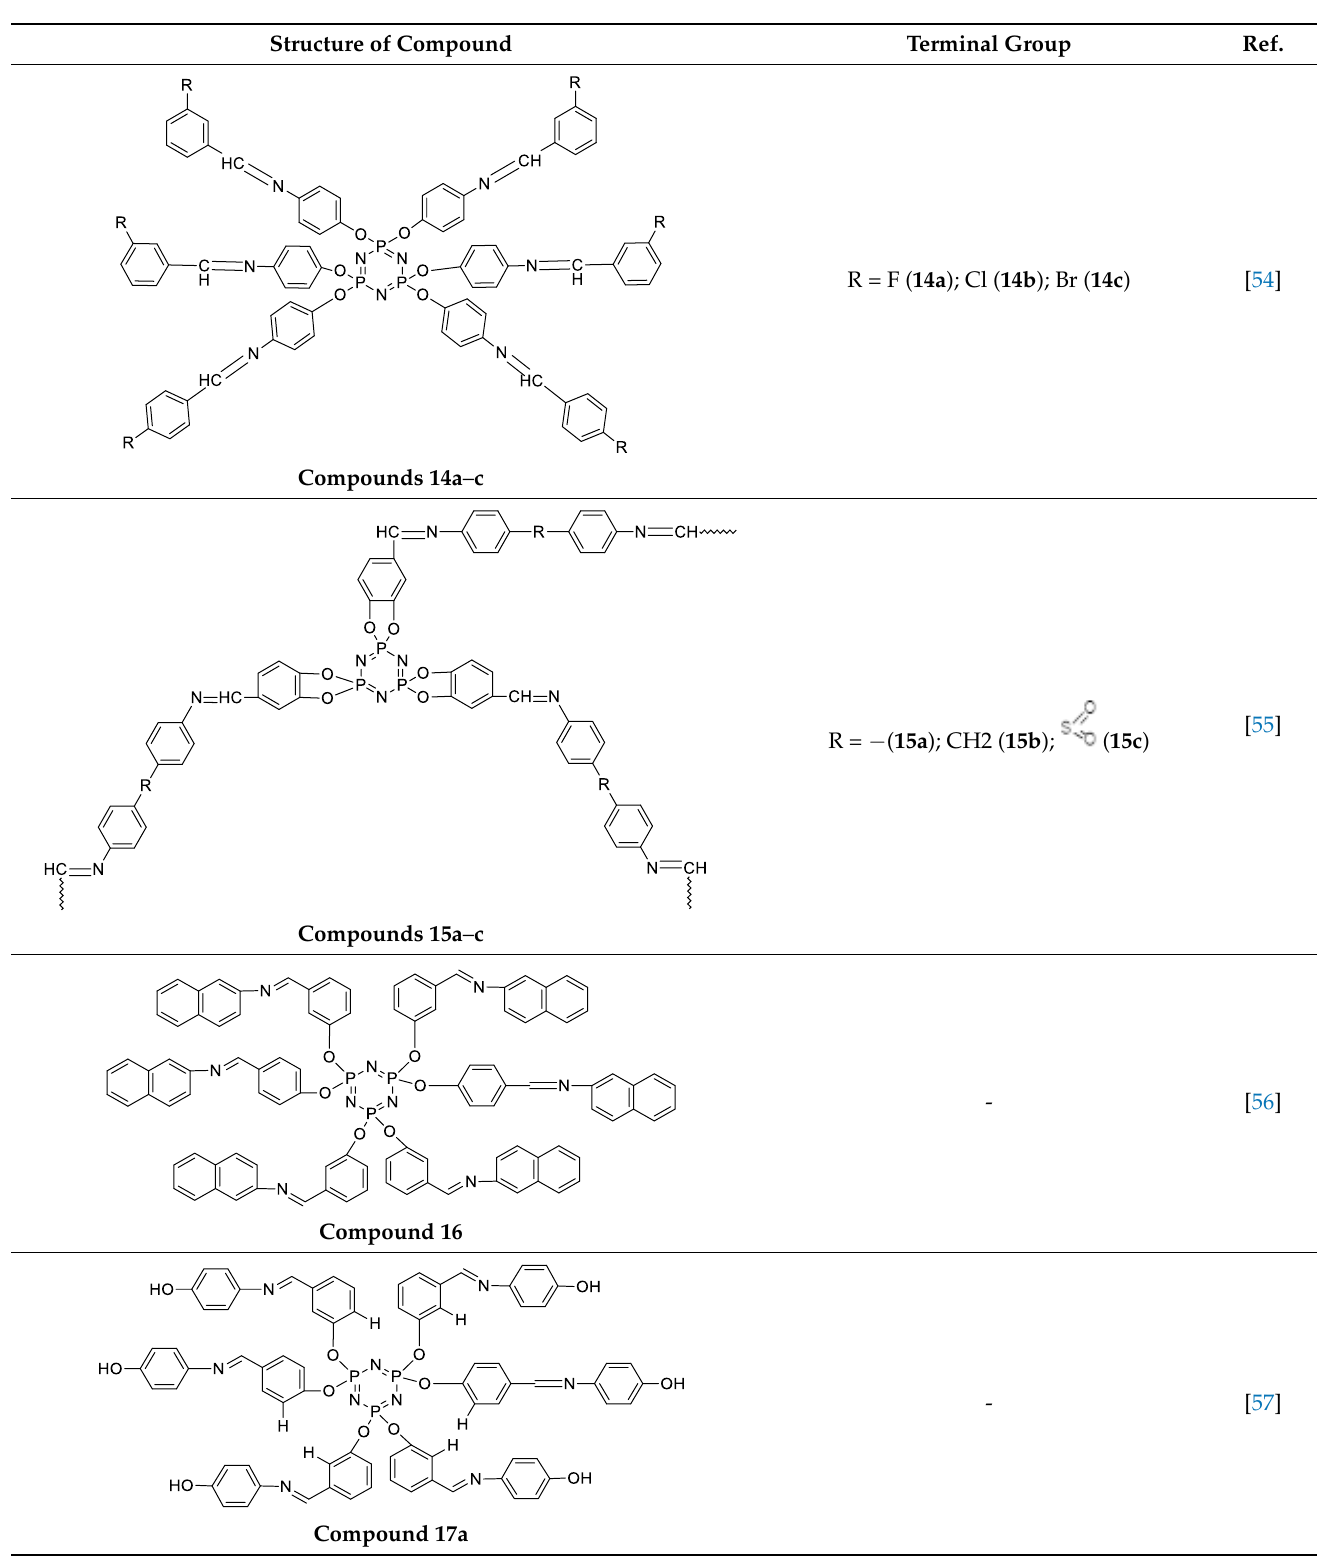
Table 6. Cyclotriphosphaze compounds containing different side arms.